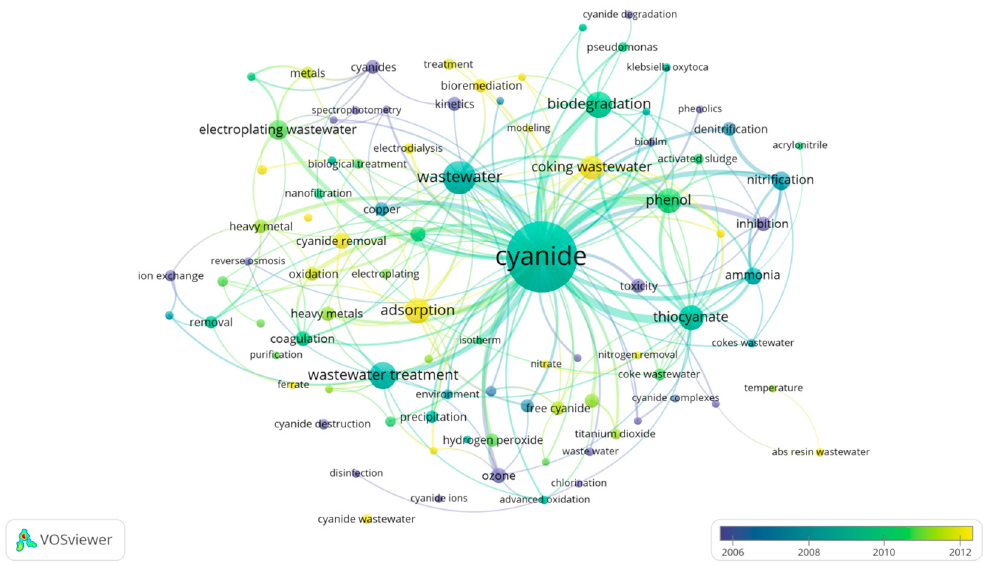
Figure 1. Keyword correlation map. Database: Web of Science. 464 documents. Date of consultation: 22 February 2018. Built with VOSViewer v1.6.7.